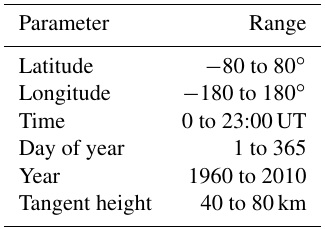
Figure 10. κ values for a random set of 25000 locations and times. The horizontal line marks the median (14rad − 1 ) . Table 5. Parameter ranges for random κ